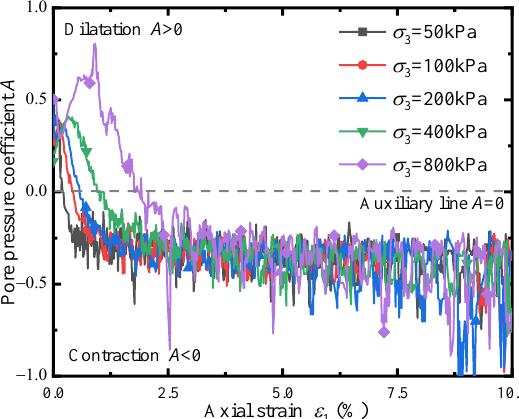
Figure 6. Relationships between pore pressure coefficient and axial strain.